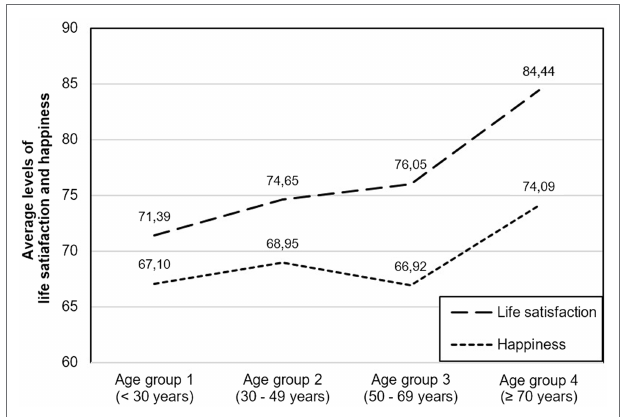
FIGURE 4 | Average levels of life satisfaction and momentary happiness in different age